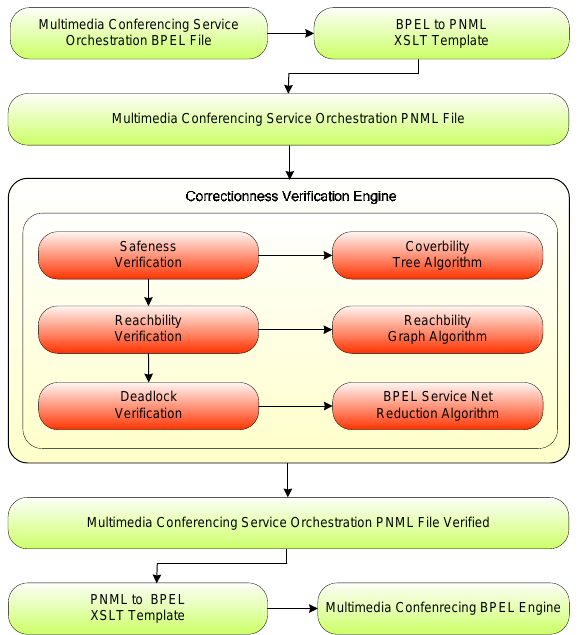
Fig.22. V erification for conference services orchestration